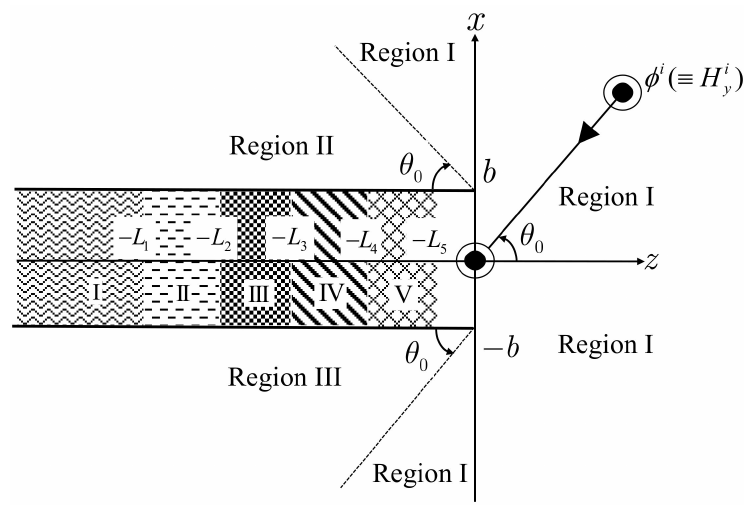
Figure 1. Geometry of the